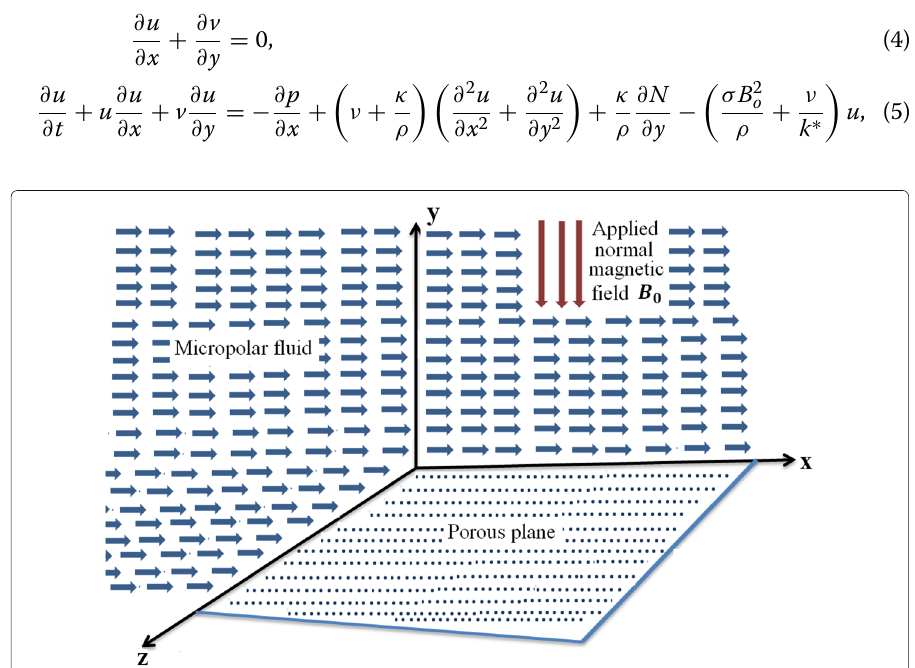
Fig. 1 Two dimensional flow of micropolar fluid in the presence of normal magnetic field on porous